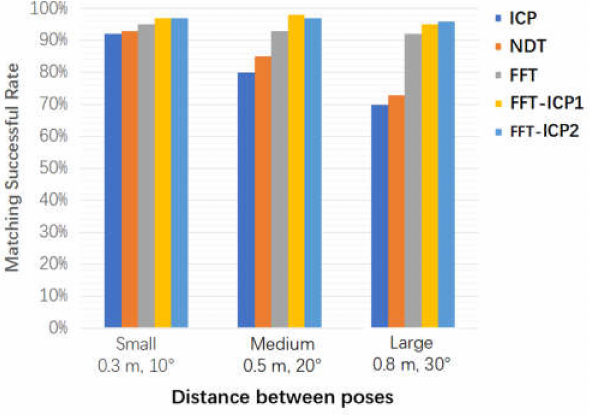
Figure 10. Results of the matching success rates for different